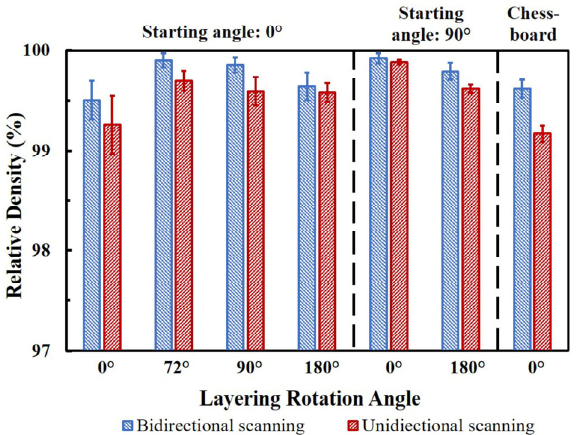
Figure 10. Density of parts made using different scanning strategies. Note: the scale bar starts from 97%, and all the samples showed over 99% density.